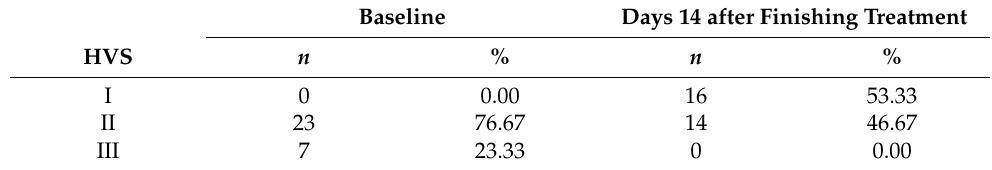
Table 1. Characteristics of acne vulgaris severity in terms of the Hellgren–Vincent Scale (HVS) among participants of the acne vulgaris (AV) group ( n =